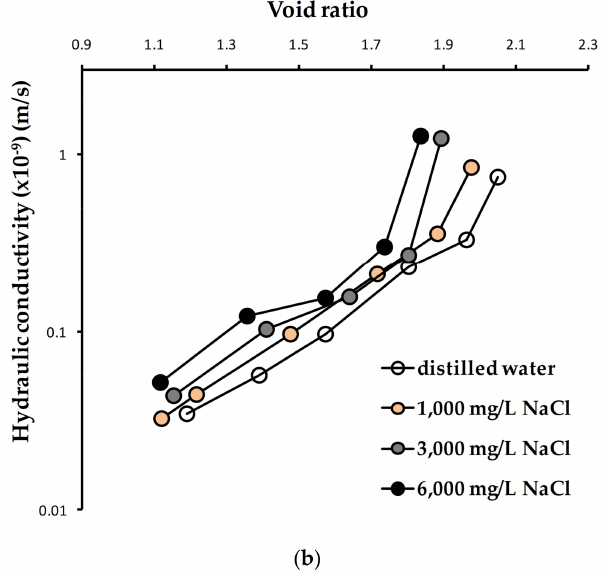
Figure 11. Changes in hydraulic conductivity ( k ) during compression at various porewater salt concentrations for ( a ) Semarang clay; and ( b ) Demak clay.